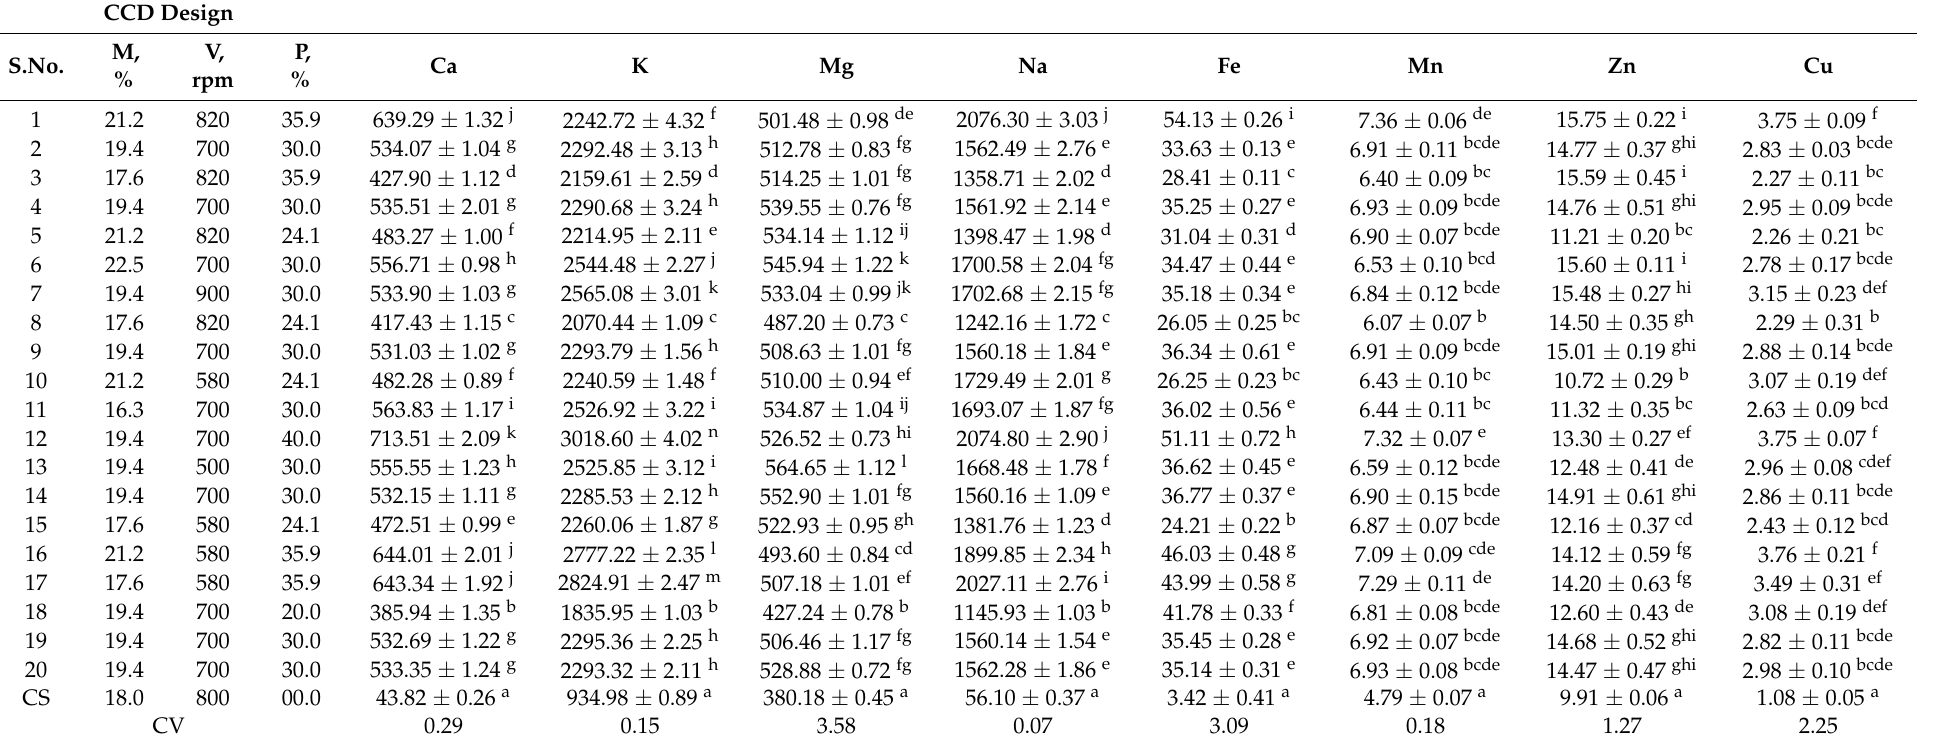
Table 3. Mineral contents in extrudates and control sample